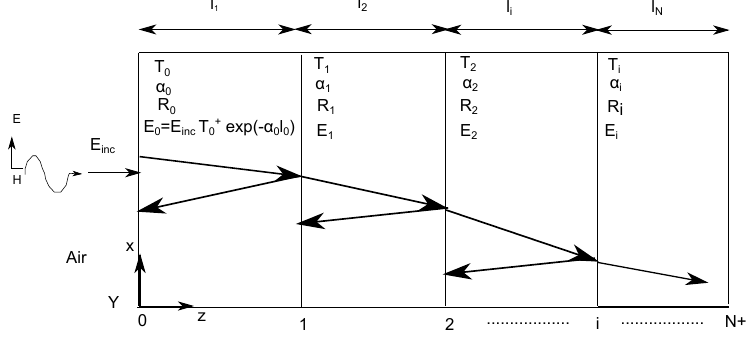
Figure 4. Plane-wave propagation in a multilayer